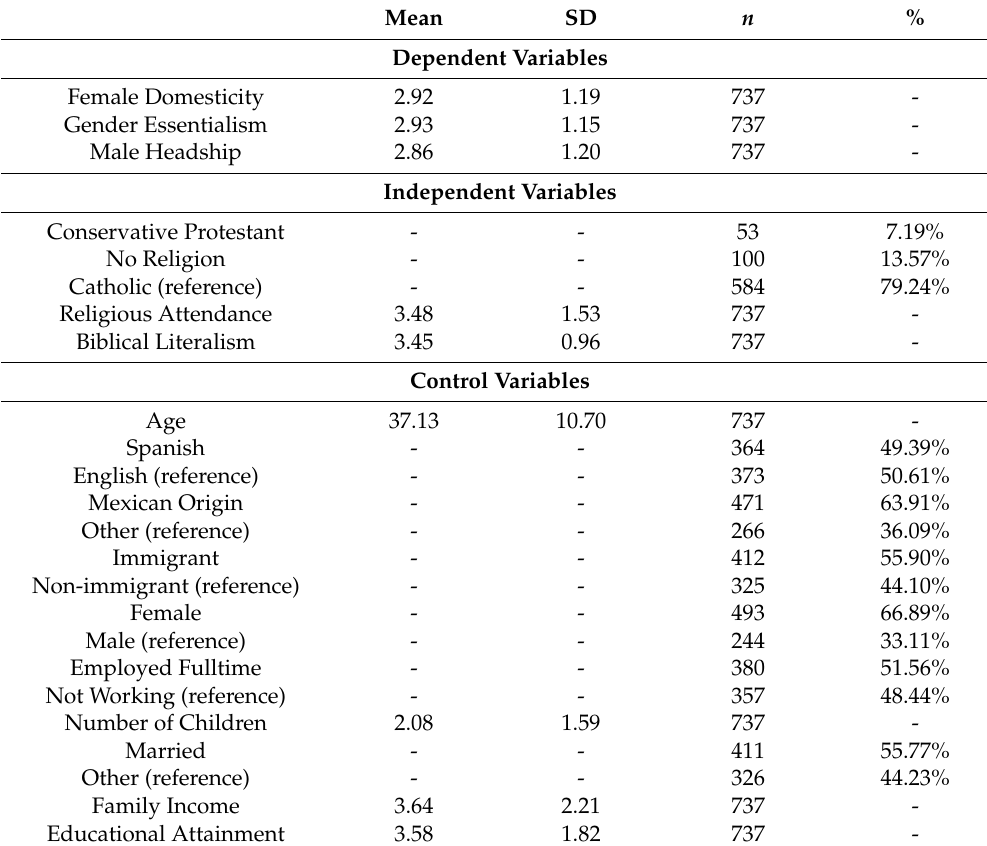
Table 1. Sample Characteristics after Multiple